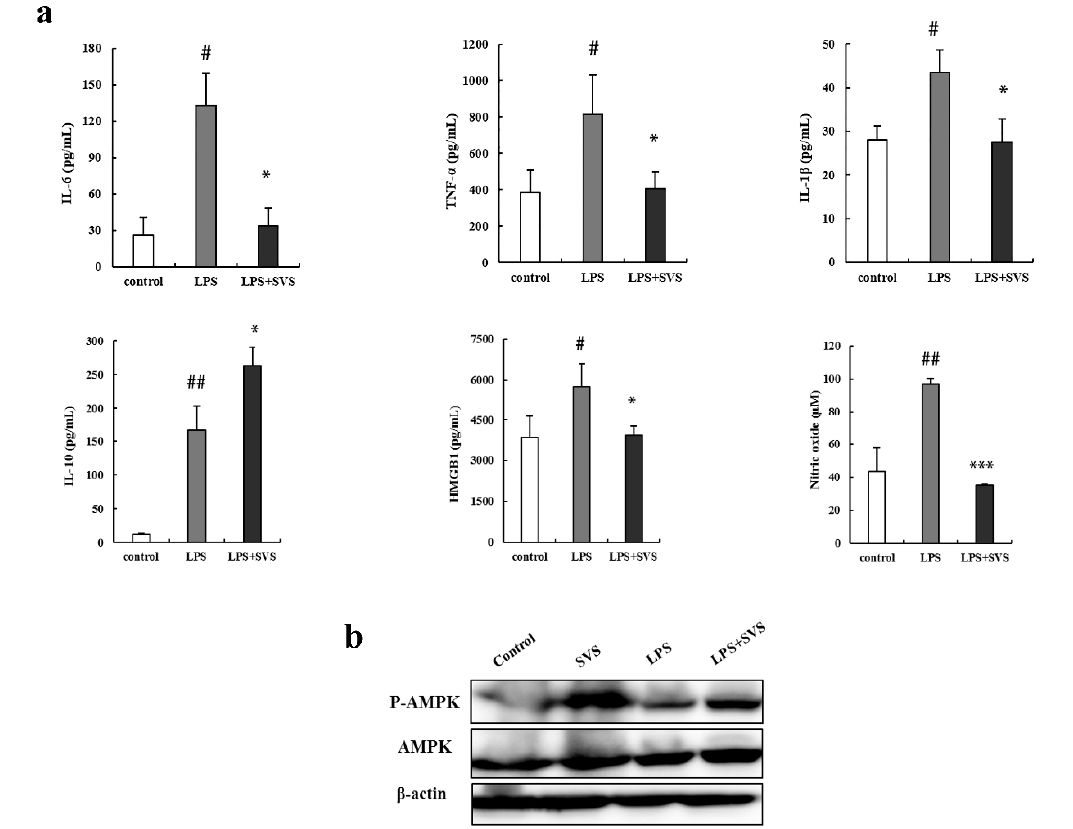
Figure 10. Stevioside attenuated inflammatory responses and protected mice from LPS-induced excessive cytokine-mediated lethal shock. ( a ) Serum levels of IL-6, TNF- α , IL-1 β , IL-10, and HMGB1 were detected by ELISA and NO were detected by the Griess reaction; ( b ) Representative immunoblots of AMPK and phosphor-AMPK (p-AMPK) in periphery blood mononuclear cells of mice with lethal shock. # p < 0.05, ## p < 0.01 versus control group; * p < 0.05, *** p < 0.001 versus LPS-treated group. SVS, stevioside.